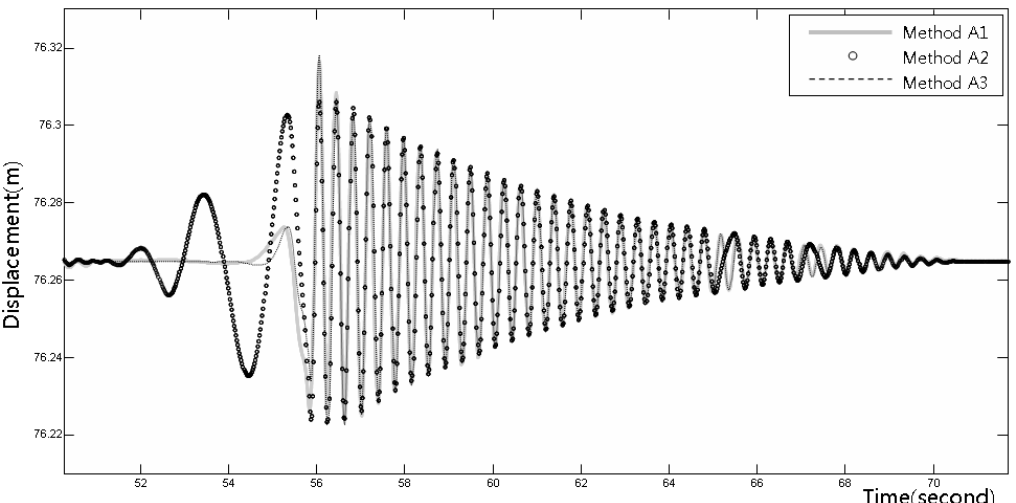
Figure 11. Displacements measured from the accelerometer using the processing